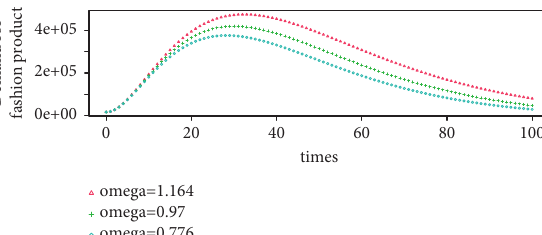
Figure 9: Simulation of demand for fashion products at different values of omega; ω � 0 . 776 , 0 . 97and 1 . 164. As ω increases through these rates, the demand for fashion products increases.